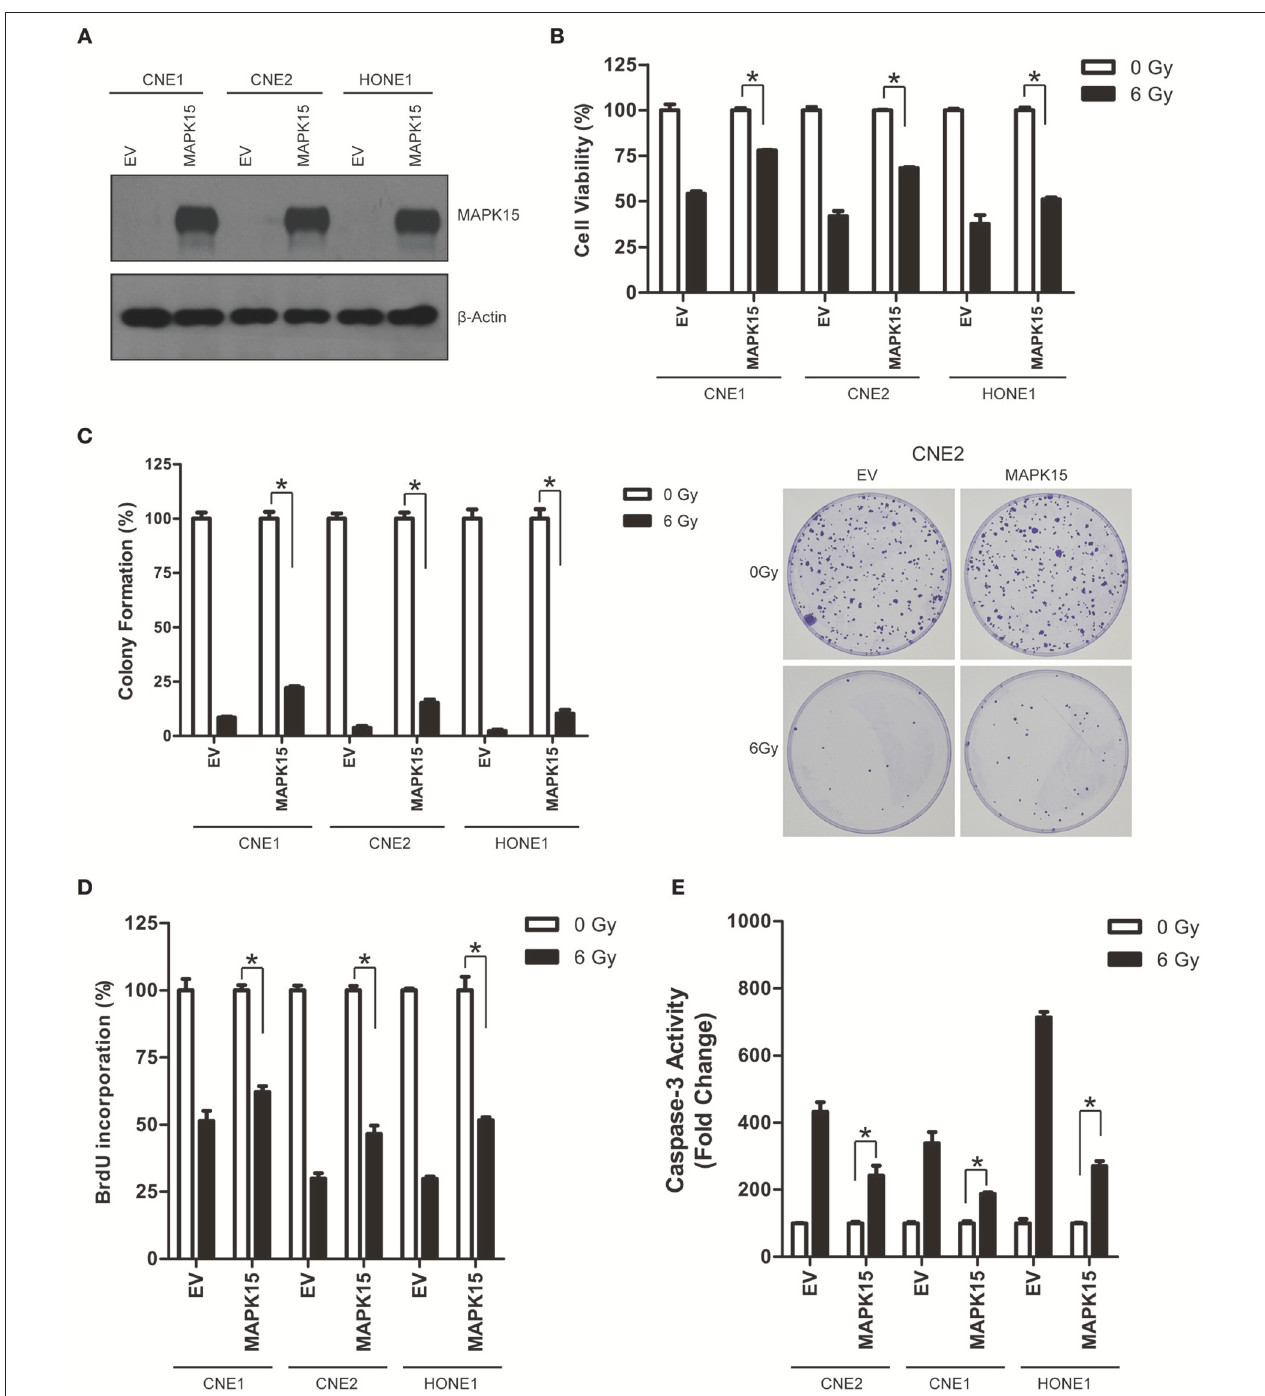
FIGURE 6 | Over-expression of MAPK15 promotes radioresistance in NPC cells. (A) Transfection of MAPK15 plasmid considerably increased MAPK15 protein expression in three NPC cell lines CNE1, CNE2, and HONE1. (B) Over-expression of MAPK15 increased radioresistance in NPC cells. The cell viability in vector control (EV) or MAPK15 without ionizing irradiation was regarded as 100%, respectively. MAPK15 (6Gy) vs. EV (6Gy), n = 3, * P < 0.05. (C) Over-expression of MAPK15 increased colony formation after irradiation in NPC cells. The colony formation in EV or MAPK15 without ionizing irradiation was regarded as 100%, respectively. MAPK15 (6Gy) vs. EV (6Gy), n = 3, * P < 0.05. (D) Over-expression of MAPK15 enhanced the proliferative potential of NPC cells exposed to irradiation. The BrdU incorporation in EV or MAPK15 without ionizing irradiation was regarded as 100%. MAPK15 (6Gy) vs. EV (6Gy), n = 4, * P < 0.05. (E) Over-expression of MAPK15 decreased caspase-3 activity following irradiation in NPC cells. The caspase-3 activity in EV or MAPK15 without ionizing irradiation was regarded as 100%, respectively. MAPK15 (6Gy) vs. EV (6Gy), * P < 0.05.